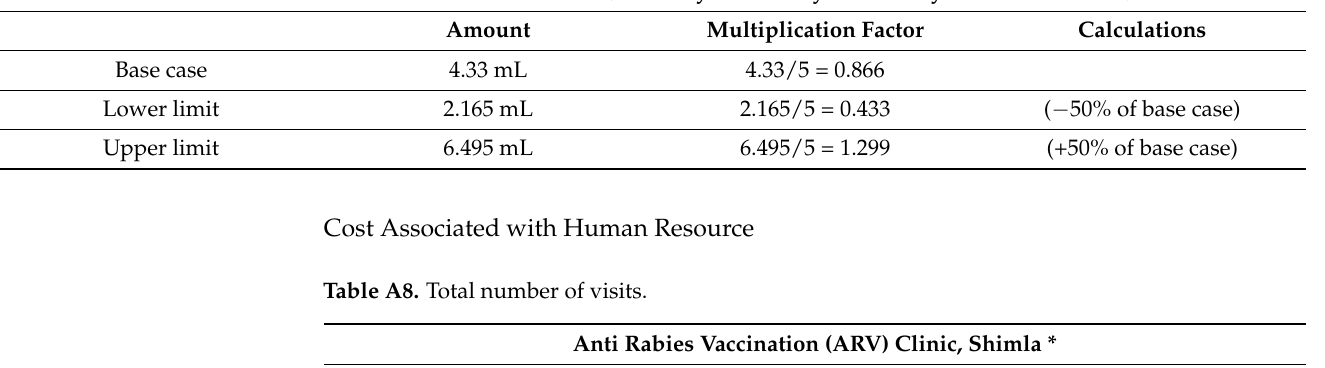
Table A7. Sensitivity Analysis for RIG.